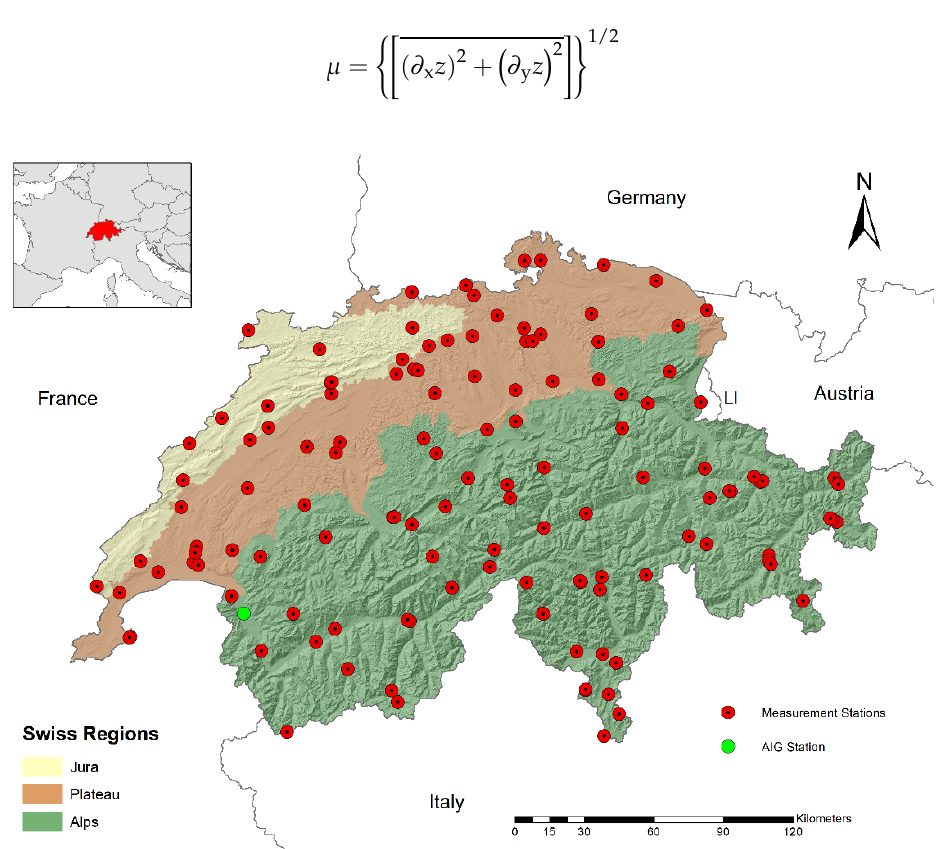
Figure 1. Map of Switzerland and location of the meteorological stations. AIG station is marked in green.